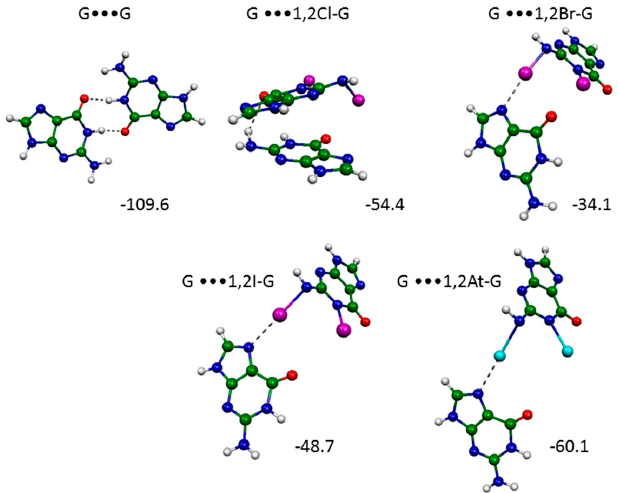
Table 2. Selected geometrical parameters (distances in Å; angles in degrees) and van der Waals ratios